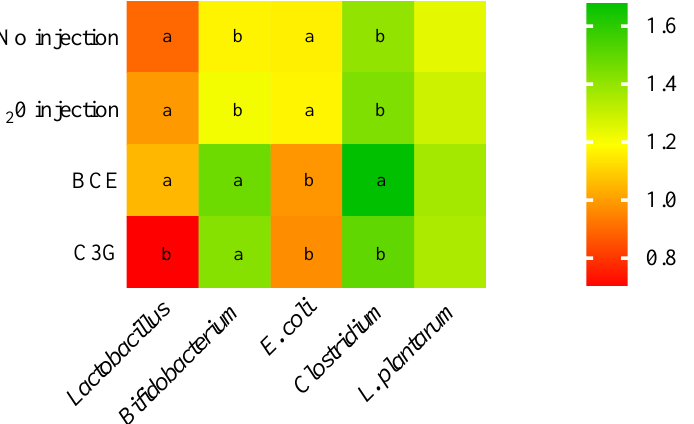
Figure 2. The effect of intra-amniotic black corn extract administration on the bacterial population from cecal content. The relative abundance is expressed in arbitrary units (AU). Values are means ± SED, n = 5 animals/group. BCE: black corn extract; C3G: cyanidin-3-glucoside. The treatment groups not indicated by the same letter are different ( p < 0.05) by the post-hoc Duncan test. Squares without any letters: no difference among the treatments ( p > 0.05).